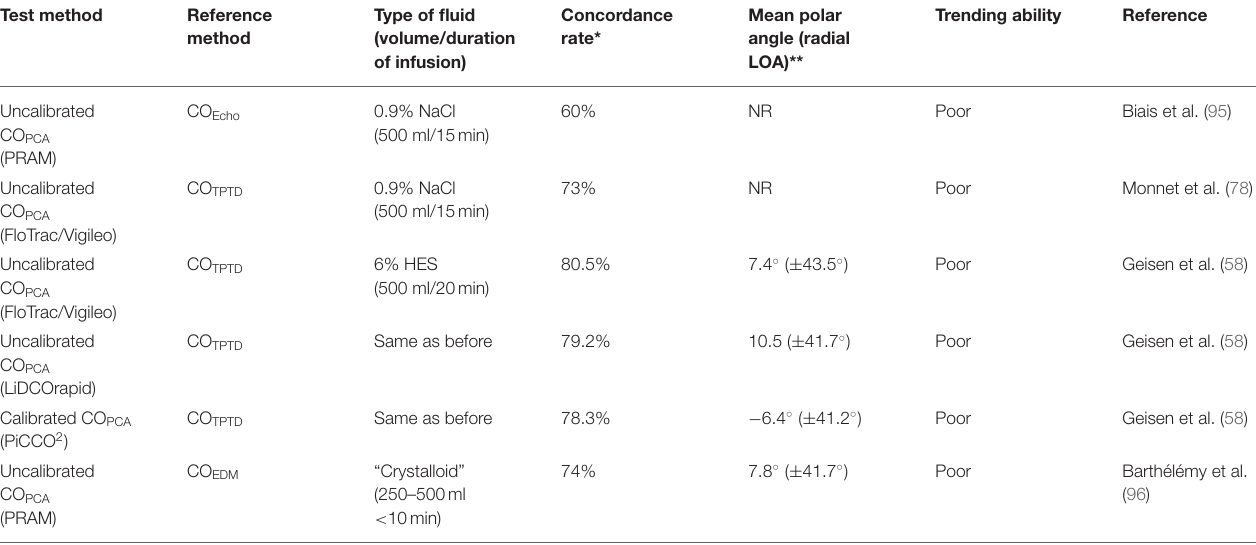
* Concordance rates based on 4-quadrant plot analysis: > 95, between 90 and 95%, and < 90%, indicate good, acceptable (or marginal), and poor trending ability, respectively (63). ** Mean polar angles and radial limits of agreement based on polar plot analysis: mean polar angle ≤ 5 ◦ and radial limits of agreement ≤ 30 ◦ indicate good trending ability (63).